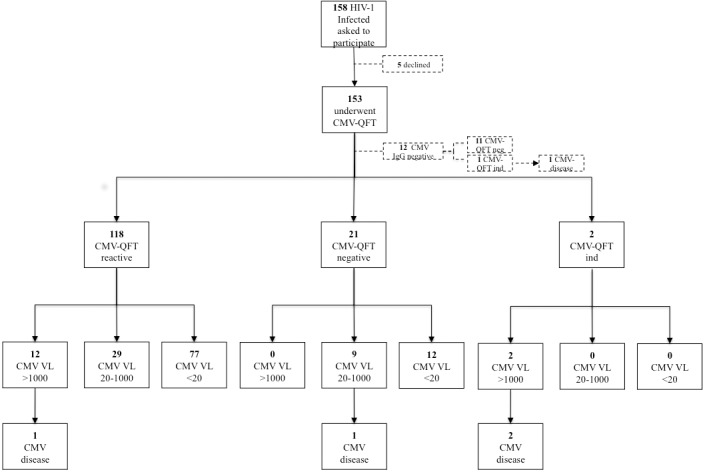
Study profile for HIV-1 infected individuals who underwent CMV-QFT testing.CMV-QFT = Cytomegalovirus-QuantiFERON assay.